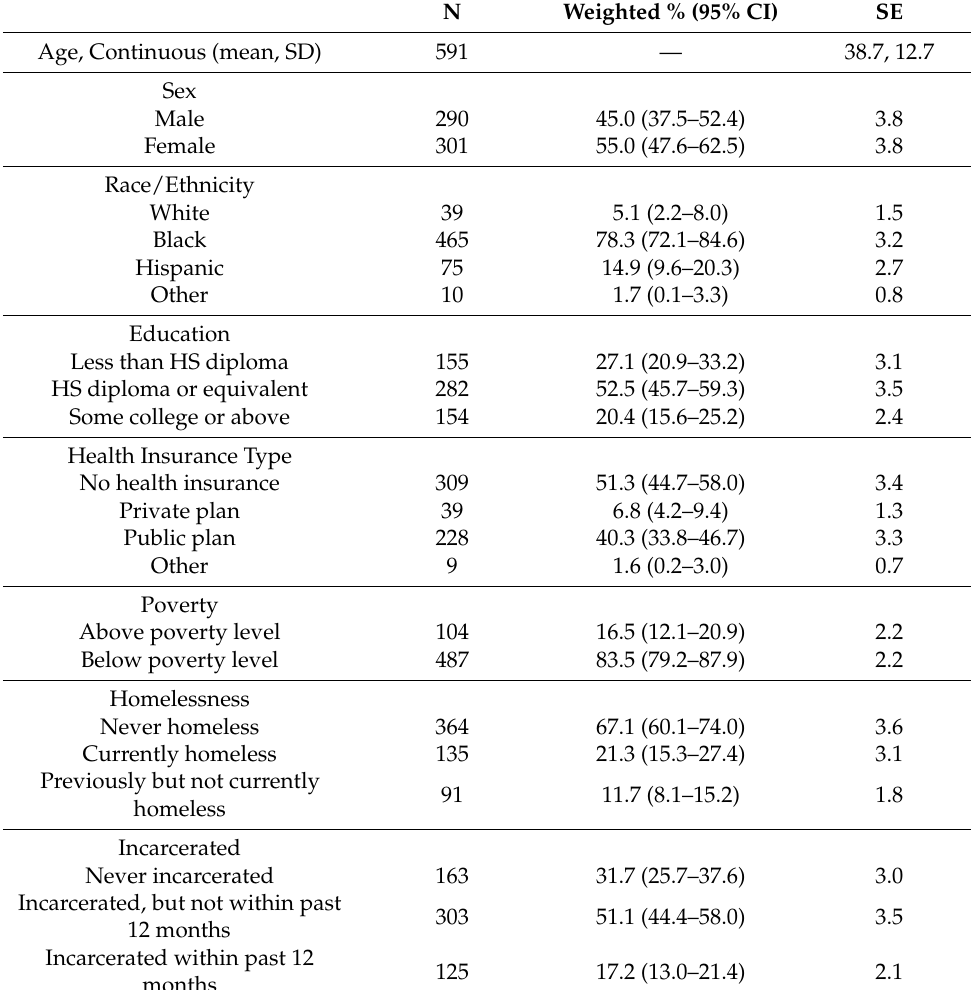
Table 1. Demographic characteristics of the study population.